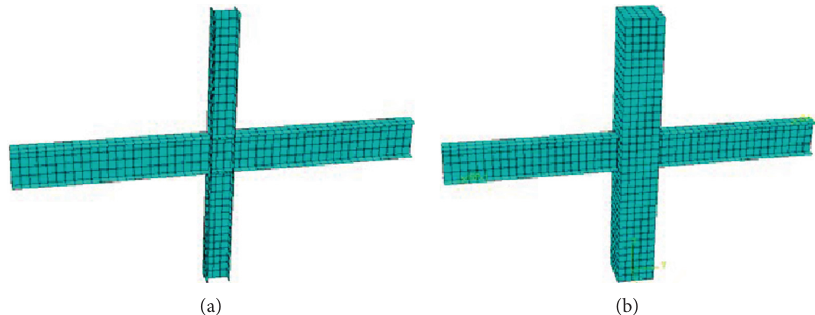
Figure 17: Meshed elements. (a) Joint from steel elements. (b) Joint from concrete column/steel beam.